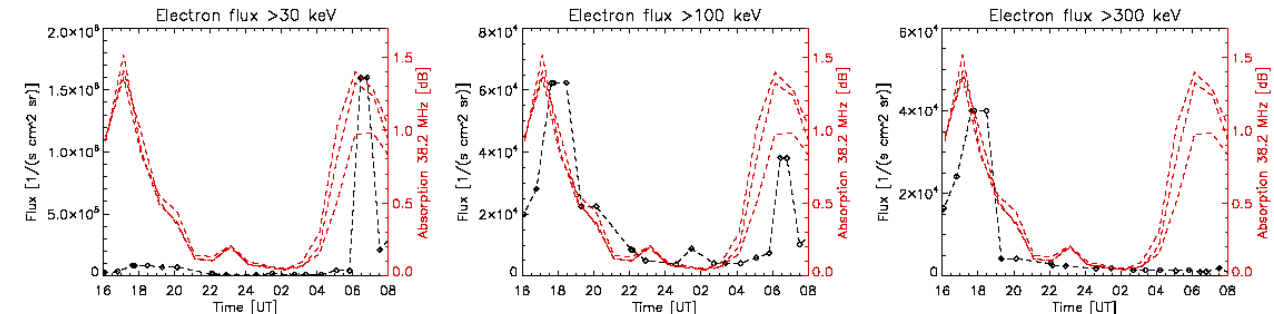
Fig. 4. The black diamonds show the electron flux in three energy channels, > 30keV, > 100keV, and > 300keV above Andøya found by interpolating measurement from the MEPED vertical detector on NOAA 15, 16, and 17 on 21–22 January 2005. The red dashed lines show the cosmic radio noise absorption measured by IRIS in beam 8, 15, and 22.